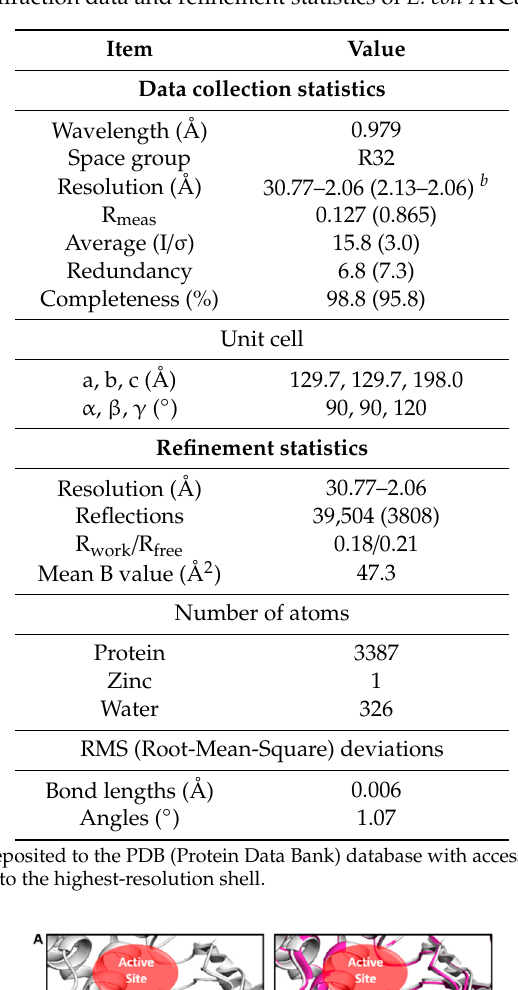
Table 1. X-ray di ff raction data and refinement statistics of E. coli ATCase holoenzyme a .